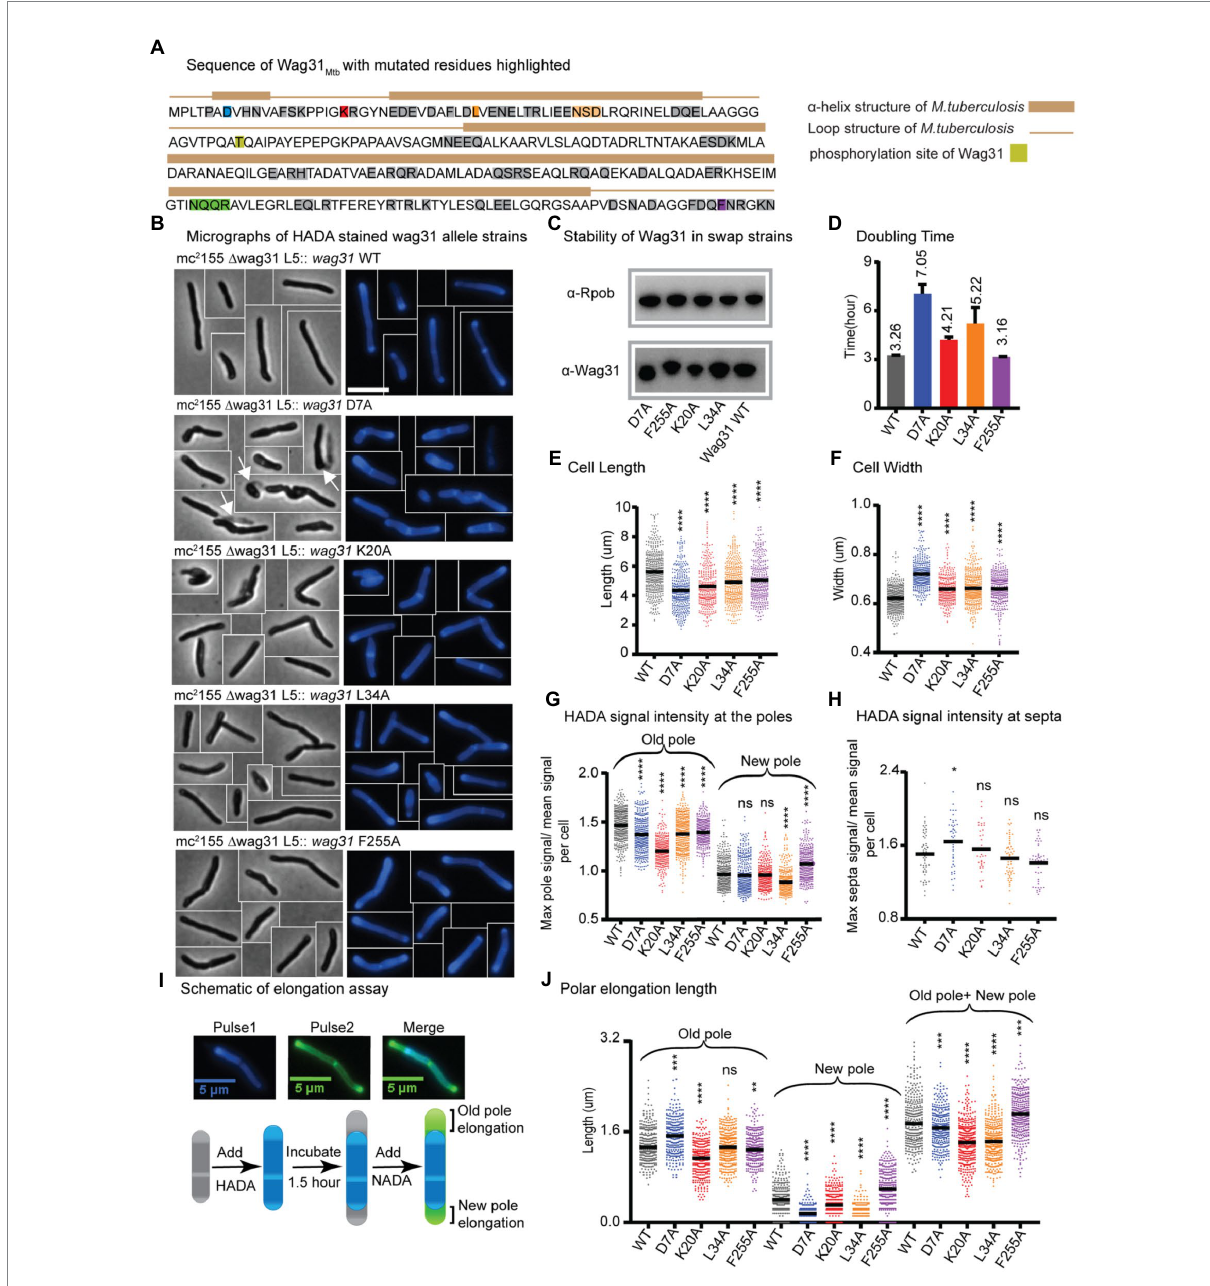
FIGURE 1 Wag31 has multiple distinct roles in both elongation and division. (A) Sequence of Wag31 from Mycobacterium tuberculosis . The residues mutated in the alanine scanning experiments are highlighted. (B) Phase (left) and fluorescence (right) images of Msmeg wag31 allele strains stained with HADA. The scale bar is 5 microns, and it applies to all images. Several cells from different images of the same strain are cropped together. White arrows indicate the ghosts in D7A (C) Western blots of Wag31 WT and mutant proteins in wag31 allele strains using α -Wag31 antibody. The epitope used to raise the antibodies is KPPIGKRGYNEDEVDAFLD, of which K is K20. Thus, the decreased signal seen in the K20A strain may be due to decreased association of the antibody against the mutant protein. RpoB serves as a loading control. (D) Doubling times of Msmeg cells expressing wag31 WT or alanine mutants. The means (on top of bars) are an average of three biological replicates. Error bars represent SD. (E) Cell lengths of the wag31 allele strains. Black bars are at the mean. (F) Cell widths of the wag31 allele strains. Black bars are at the mean. (G) Relative polar and septal (H) HADA intensity of wag31 allele strains. Equivalent to the maximum signal at one pole divided by the mean signal of that cell. (I) Schematic of elongation assay dual-FDAA staining method to measure elongation. The brackets indicate the measurements made. (J) Length of polar elongation in the wag31 allele strains, as measured by the elongation assay in I. Black bar is at the median. ns, p > 0.05, * p = < 0.05, ** p = < 0.005, *** p = <0.0005, **** p = <0.0001. All p -values were calculated by one-way ANOVA, Dunnett’s multiple comparisons test, with comparisons of mutants to the wild-type in each case. All microscopy experiments were performed on at least 100 cells from each of three independent replicate